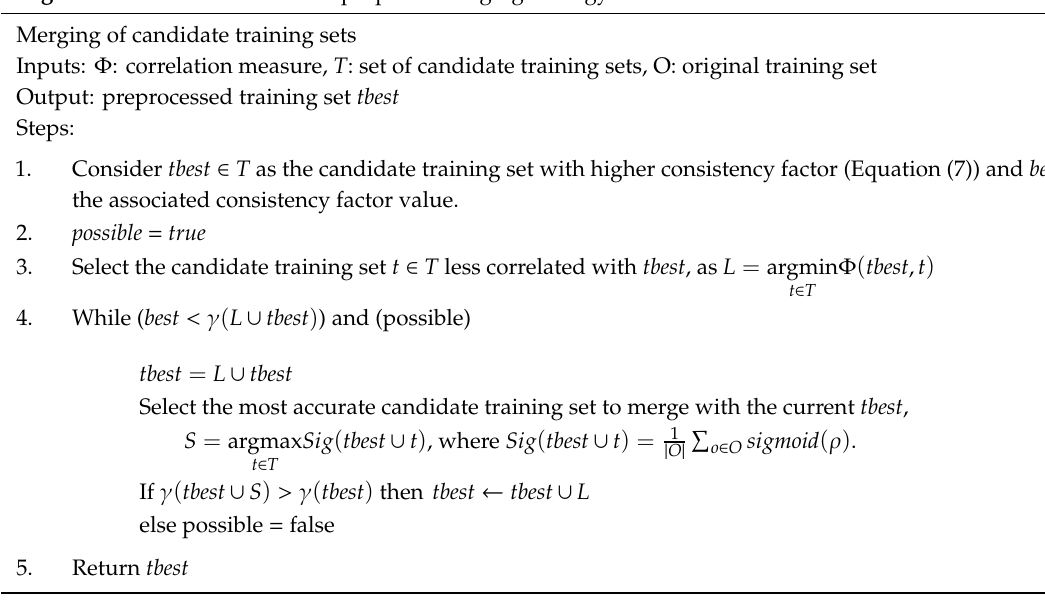
Algorithm 2. Pseudocode of the proposed merging strategy. Merging of candidate training